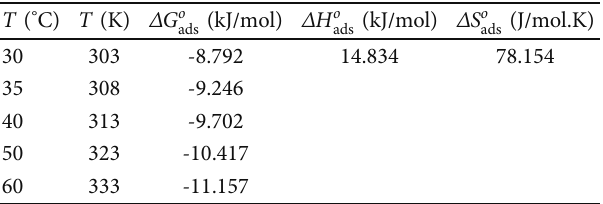
Figure 4: Van ’ t Ho ff ’ s plot for thermodynamic analysis. Table 5: Adsorption thermodynamic